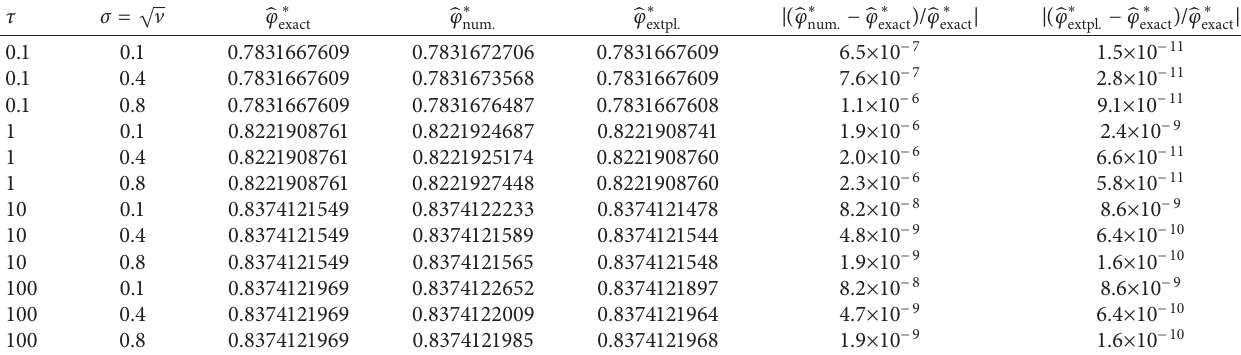
Table 3: Comparison between the exact solution 􏽢 φ ∗ solution after Richardson’s extrapolation 􏽢 φ ∗ numerical solutions are obtained with Δ τ � Δ v � 0 . 01.